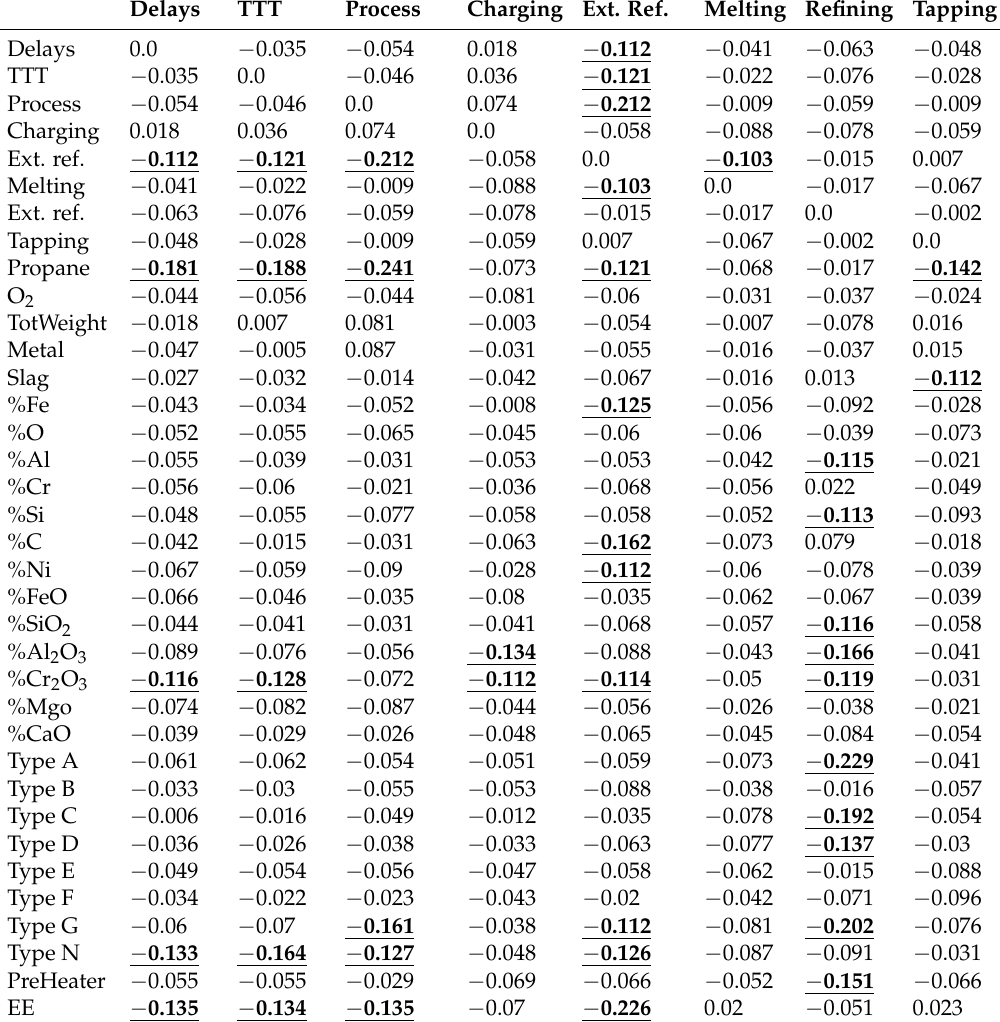
Table A3. Difference in Variable-variable distance correlation (dCor) between the training and test data. dCor values at ± 0.1, or above, is bold and